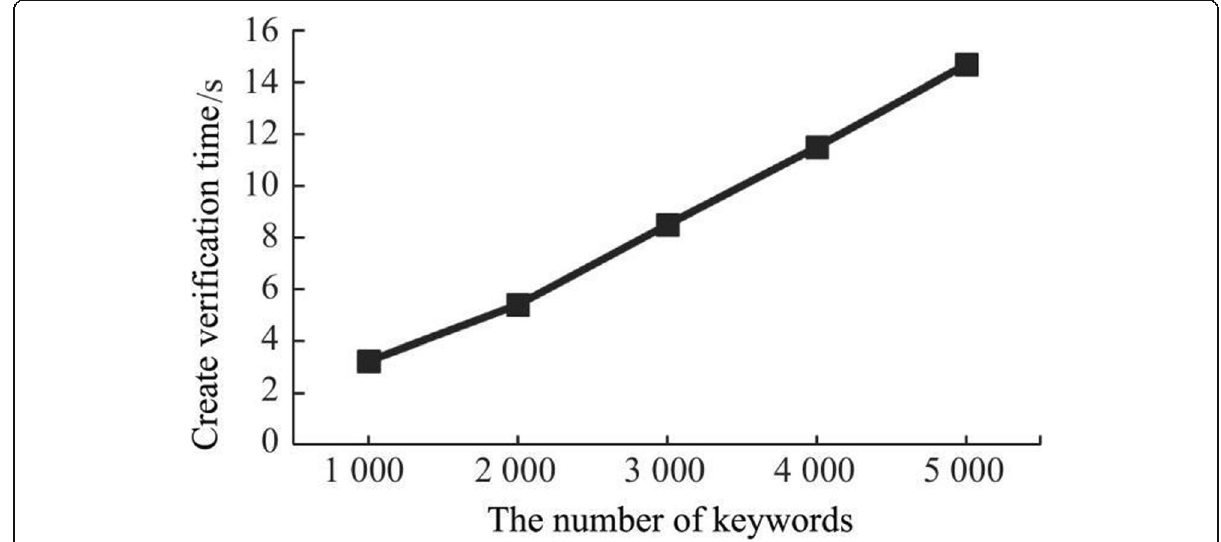
Fig. 13 Time of building verification information.